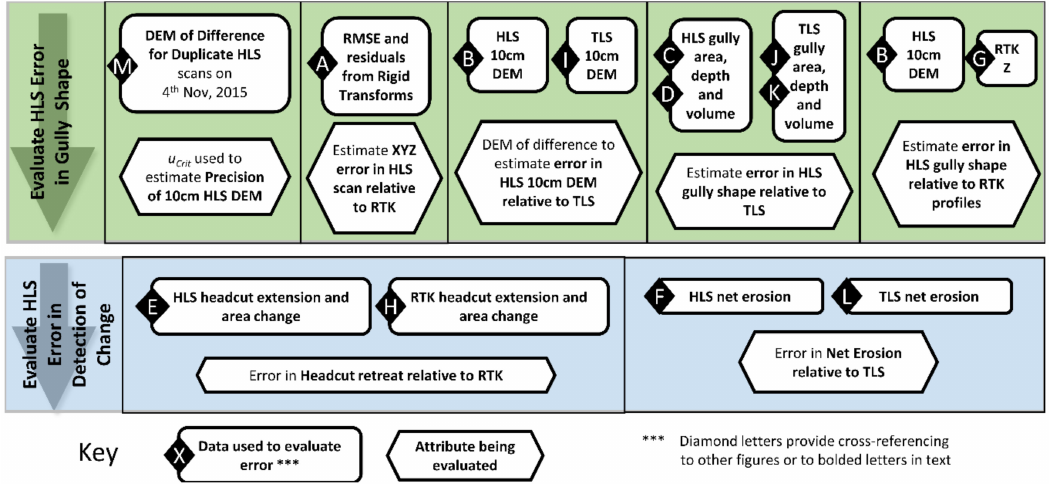
Figure 4. Methodology for evaluating error in HLS. Cross reference black diamond symbols with the workflow in Figures 2 and